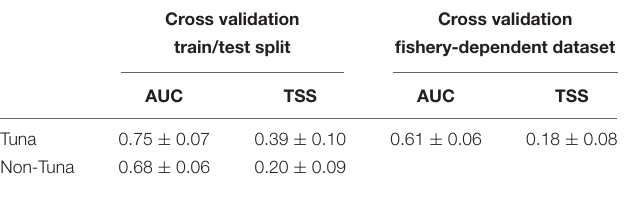
TABLE 6 | Average and standard deviation AUC and TSS values for the final models selected in each case for tuna and non-tuna species using two different datasets (fisheries-independent and fisheries-dependent) for the